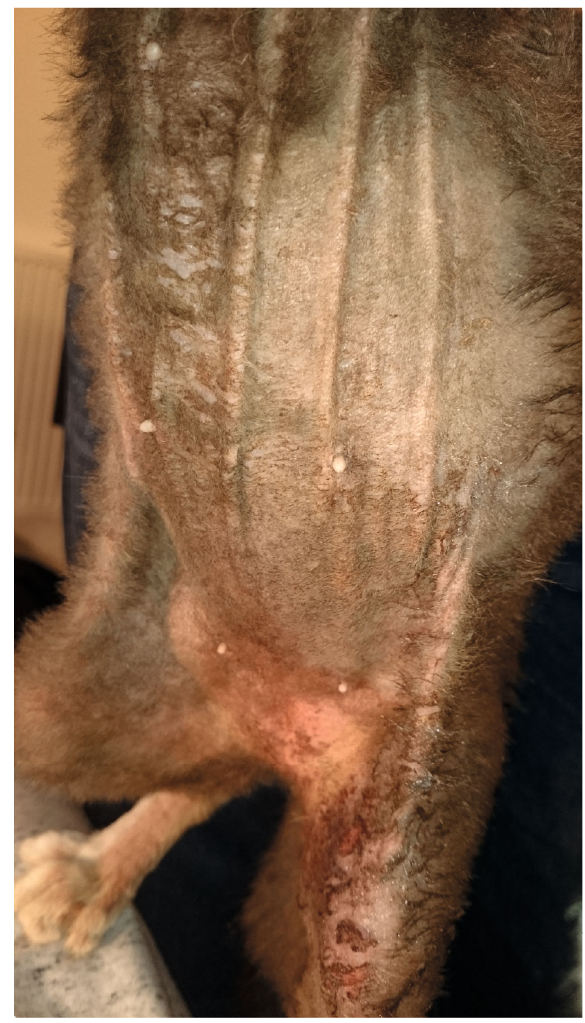
Figure 1: Ventral alopecia with brown adherent greasy scales on the skin of the ventral abdomen and hind limbs at the time of initial diagnostic